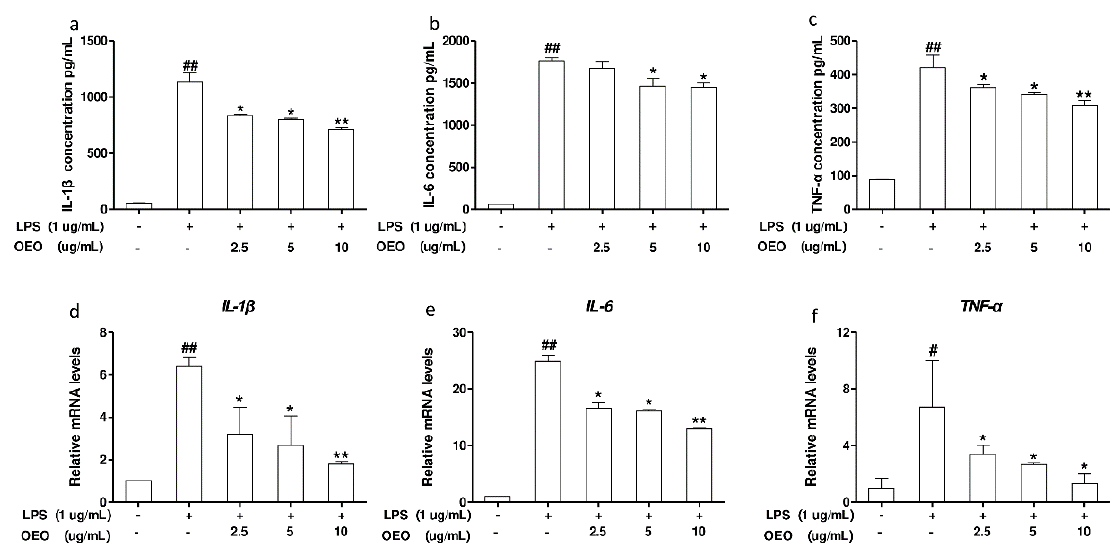
Figure 1. Oregano essential oil (OEO) inhibits lipopolysaccharide (LPS)-induced mRNA levels of pro-inflammatory cytokines expression in murine macrophage cells (RAW264.7 cells). ( a – c ) Cells were pretreated with OEO for 12 h, then incubated with 1 μg/mL LPS for 12 h. ( d – f ) Cells were pretreated with OEO for 12 h, then incubated with 1 μg/mL LPS for 1 h. The interleukin-1 beta (IL-1β), interleukin-6 (IL-6), and tumor necrosis factor-alpha (TNF-α) mRNA expression levels were measured using an RT-PCR analysis. Values represent means ± standard error of the mean (SEM), n = 3. # p < 0.05 and ## p < 0.01 compared to the control group, while * p < 0.05 and ** p < 0.01 compared to the LPS-treated group.